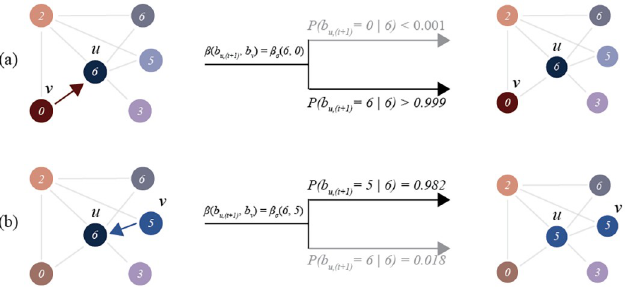
Fig 1. A graphical illustration of cognitive contagion. An illustration of cognitive contagion with the DCC contagion function described in Eq 6. (a) (Top) Given an agent u with b u = 6 and v with b v = 0, the chance of contagion is < 0.001. (b) (Bottom) Given an agent u with b